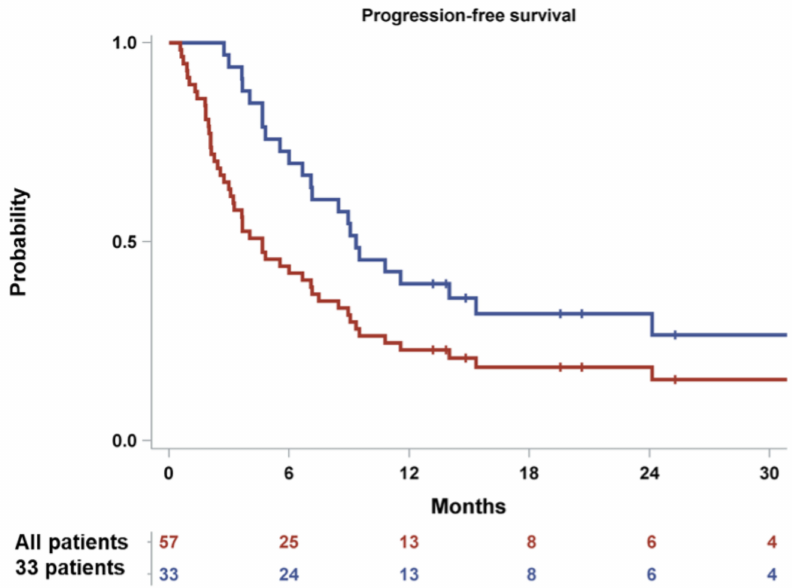
Figure 2. Kaplan–Meier curves of PFS for the enrolled patients ( n = 57) and the primary analysis cohort ( n =